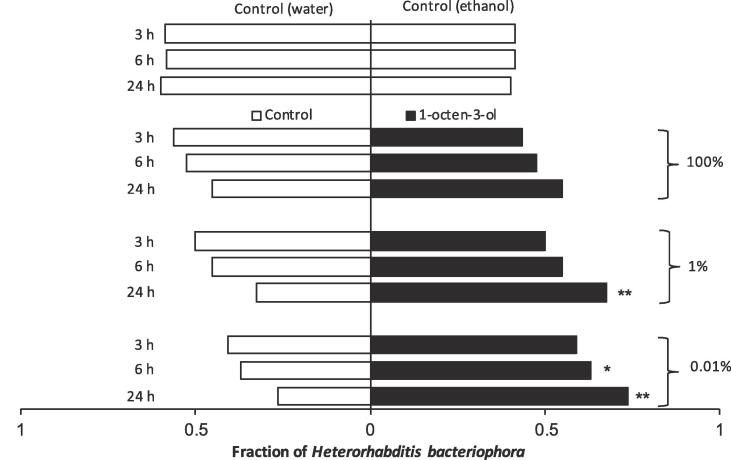
The chemotactic response of Heterorhabditis bacteriophora infective juveniles after 3, 6, and 24 hr when offered a choice between 1-octen-3-ol (right closed bars) and no odor source (left open bars). Each bar represents the choice of nematodes. * = P < 0.05, ** = P < 0.01.